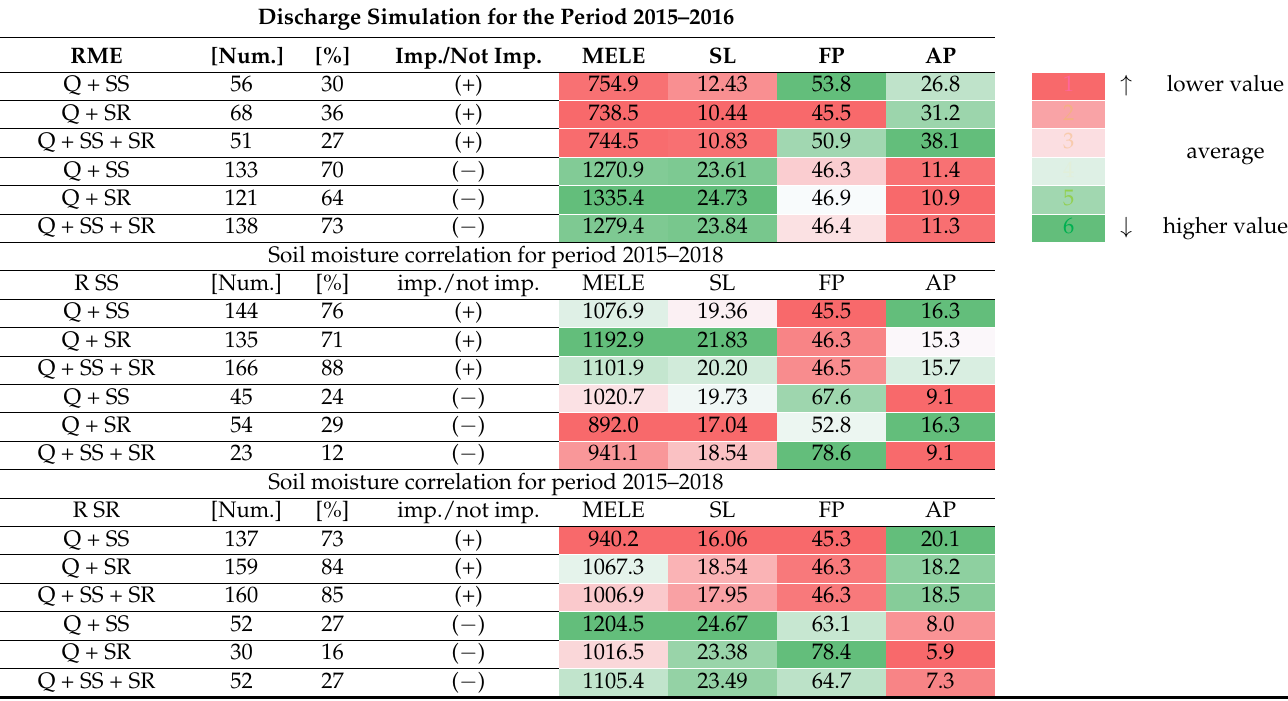
percentage of forest coverage (the median of FP ranges from 45.3 to 46.3%) and with a higher percentage of agricultural land (the median of FP ranges from 18.2 to 20.1%). The improvement of R SR was not indicated in the catchment with a higher mean slope of the terrain (the median of SL ranges from 23.4 to 24.7%), a higher percentage of forest coverage (the median of FP ranges from 63.1 to 78.4%) and with a lower percentage of agricultural land (the median of FP ranges from 5.9 to 8.0%). The similar results we also indicated in the improvements in the values of R SS. Table 9. The medians of the catchment characteristics where the values of RME, R SS and RSR were improved (+) and were not improved ( −